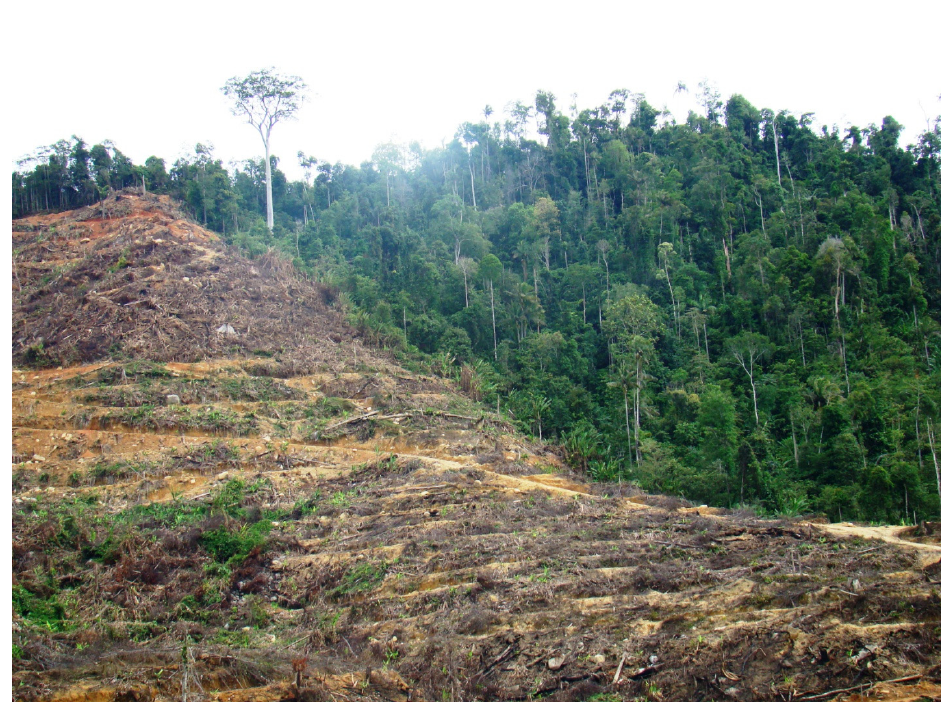
Figure 2. The forests surrounding many protected areas are being rapidly cleared or degraded. Shown is recent deforestation for oil palm plantations along the edge of Bukit Palong National Park in Peninsular Malaysia (photograph by William Laurance).